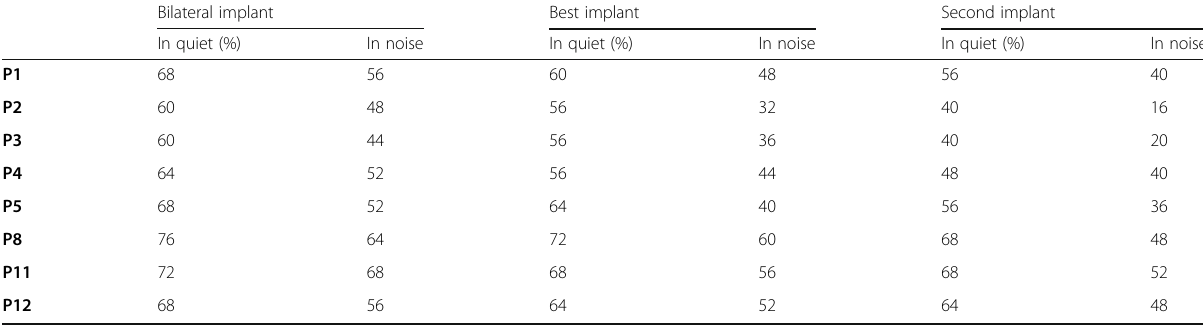
Table 7 HCST in quiet and in noise in post-lingual group 1 year after the second implant Bilateral implant Best implant Second